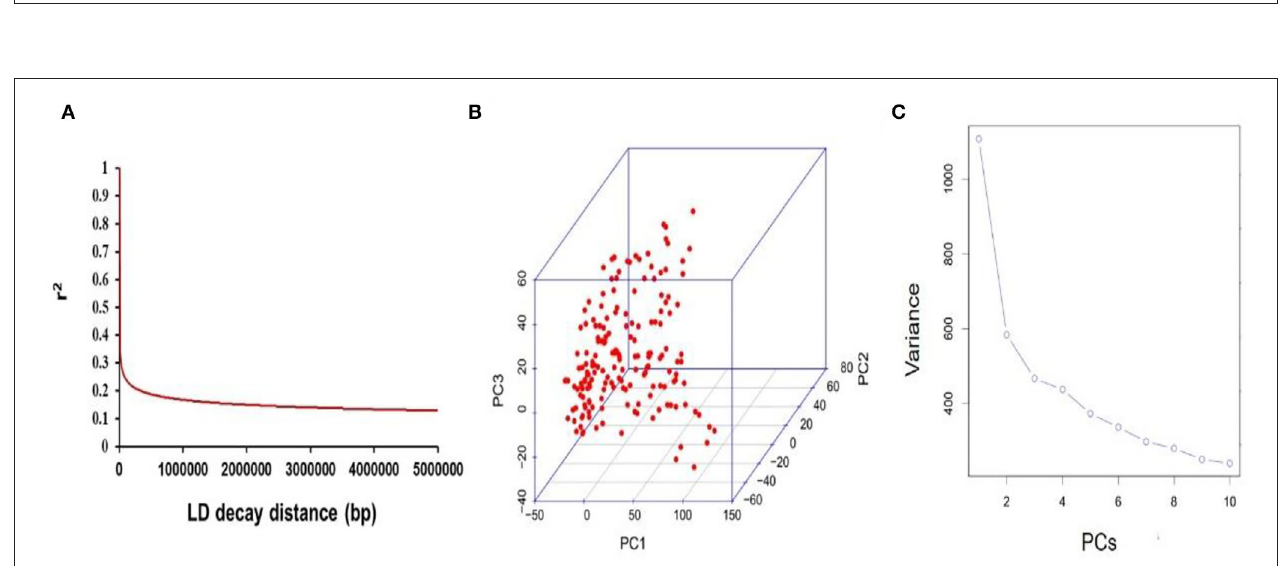
FIGURE 3 | Mapping genetic data of populations. (A) Linkage disequilibrium (LD) decay of genome-wide association study (GWAS) population. (B) The first three PCs of 25,921 SNPs used in the GWAS. (C) Population structure of soybean germplasms.